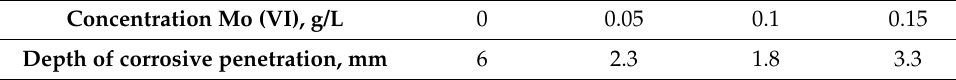
Table 3. Influence of the concentration of Mo (VI) in the precipitation solution 0.2 g/L Zr (IV) + 0.15 g/L W (VI) on the depth of corrosion penetration determined in the salt fog chamber. Concentration Mo (VI), g/L 0 0.05 Depth of corrosive penetration, mm